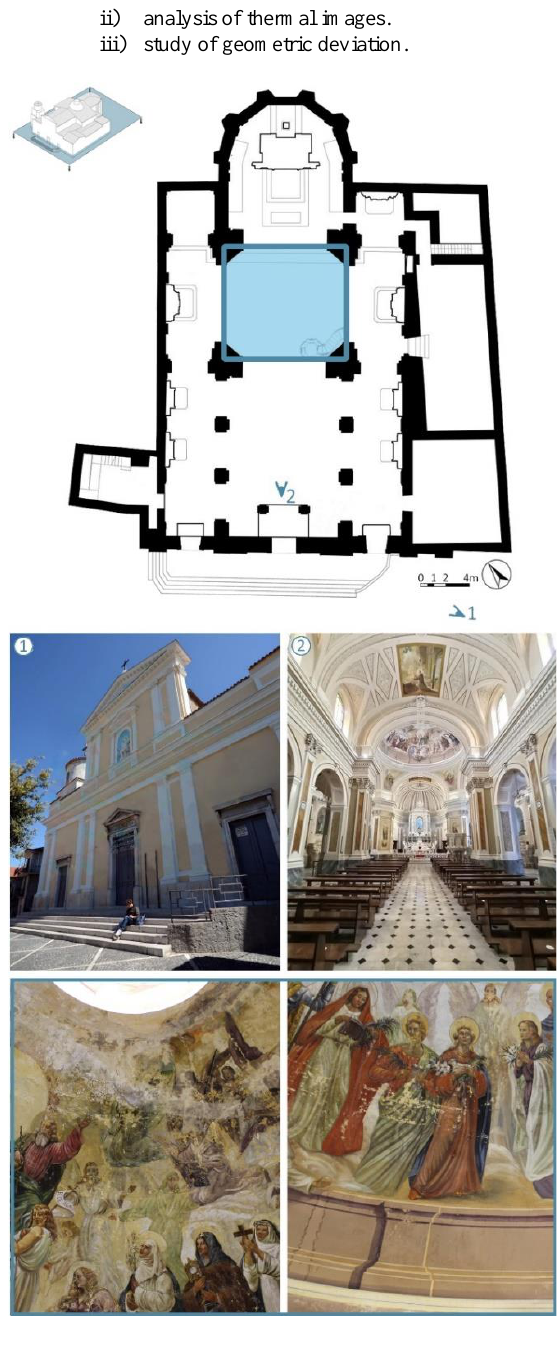
Figure 1 . Church of San Michele Arcangelo in Padula. Plan and photographs of the façade and interior. Detailed images of the damaged frescoes of the